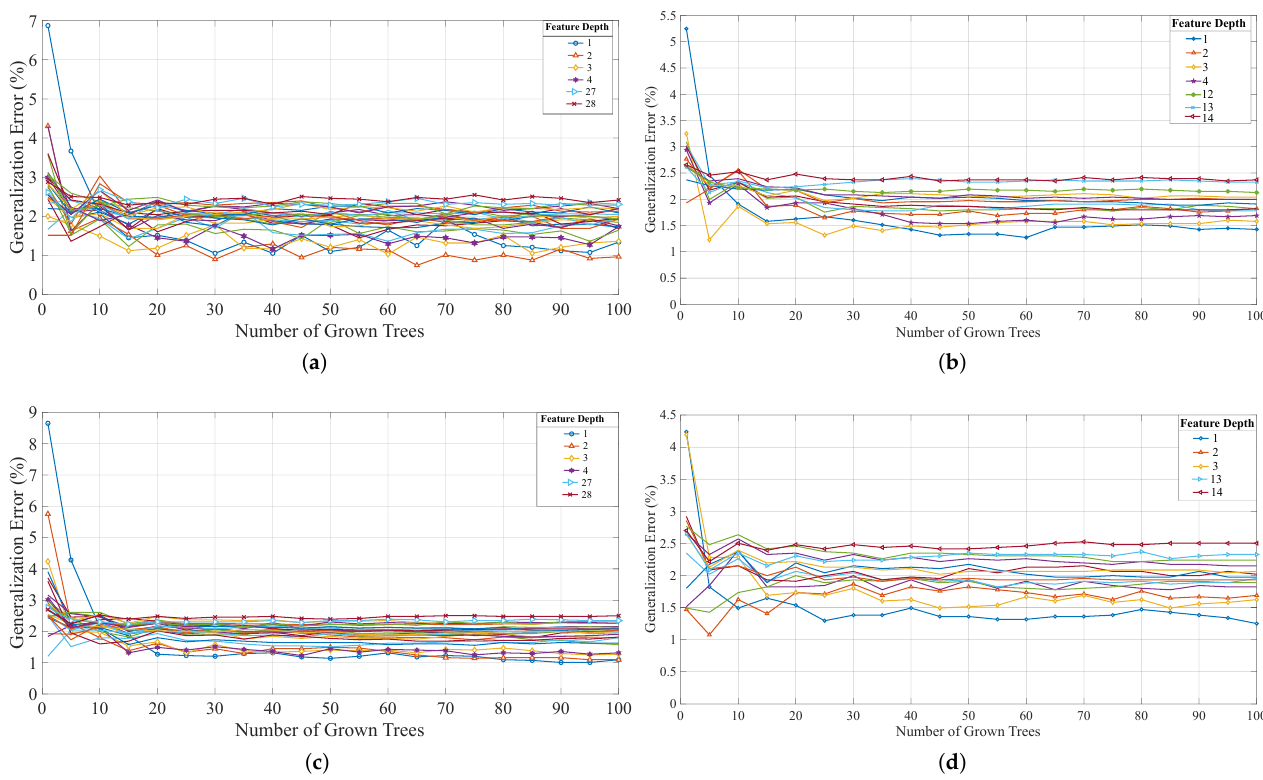
Figure 10. The generalization error results for the developed Random Forest approaches for a range of grown trees and feature depths (only certain depths marked as most follow a similar trend). ( a ) “TreeBagger” function and the original set of 28 features, where the error stabilizes between 1 and 2.15% as the number of trees increases. ( b ) “TreeBagger” function and the optimized set of 14 features, where the error stabilizes between 1.25 and 2.5% as the number of trees increases. ( c ) “fitcensemble” function and the original set of 28 features, where the error stabilizes between 1 and 2.1% as the number of trees increases. ( d ) “fitcensemble” function and the optimized set of 14 features, where the error stabilizes between 1.5 and 2.5% as the number of trees